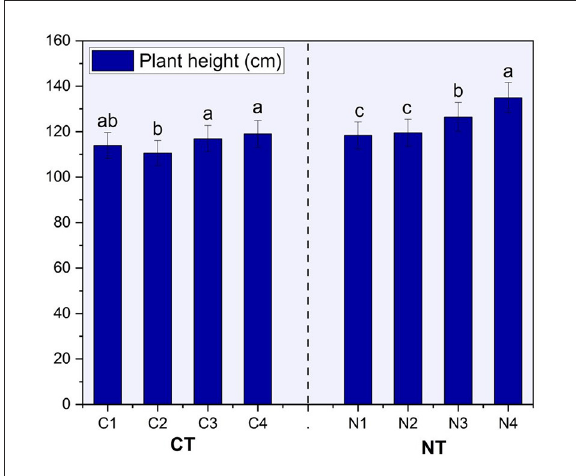
FIGURE2 Interactive effect of intercropping, mulching, and different tillage systems on plant height. Different letters above graph bars indicate significant differences p ≤ 0.05).